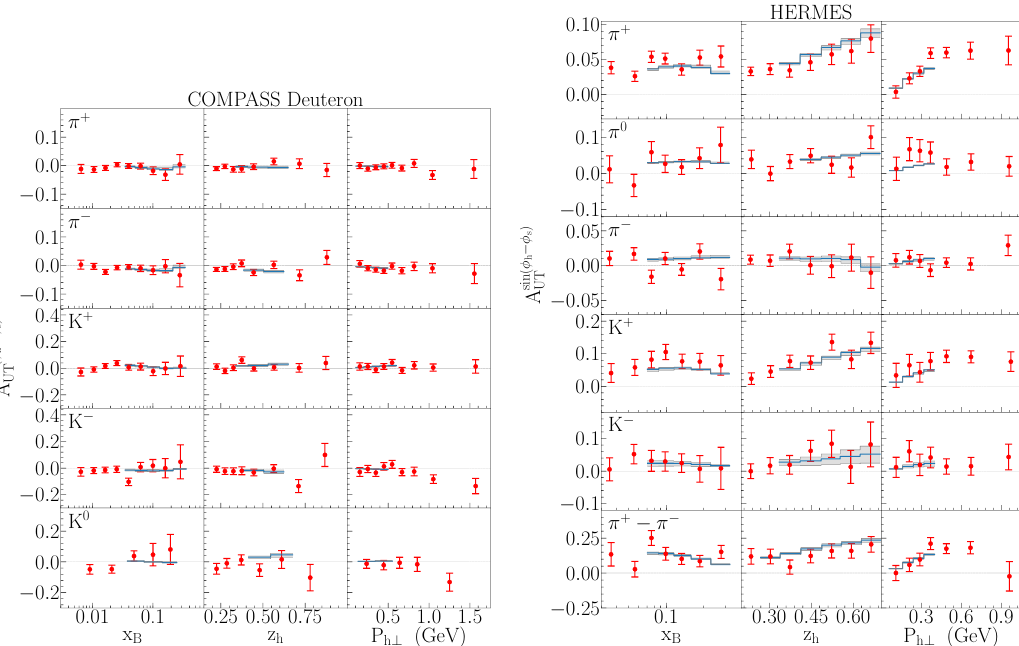
Figure 8 . Left: the COMPASS deuteron target measurement [44] for π + , π − , K + , K − , and K 0 from top to bottom, and as a function of x B (left), z h (middle), and P h ⊥ (right). Right: HERMES proton target measurement [41] π + , π 0 , π − , K + , K − , and ( π + − π − ) from top to bottom, and as a function of x B (left), z h (middle), and P h ⊥ (right). The data is plotted in red along with the total experimental error. The central curve in blue as well as the uncertainty band in gray are generated using the result from fit 1 in table 1.